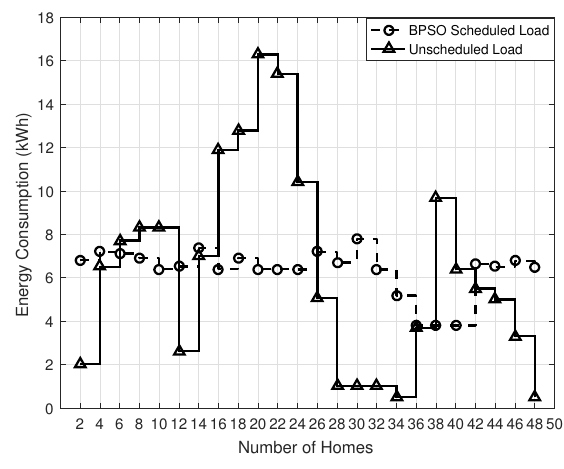
Figure 10. BPSO energy consumption.